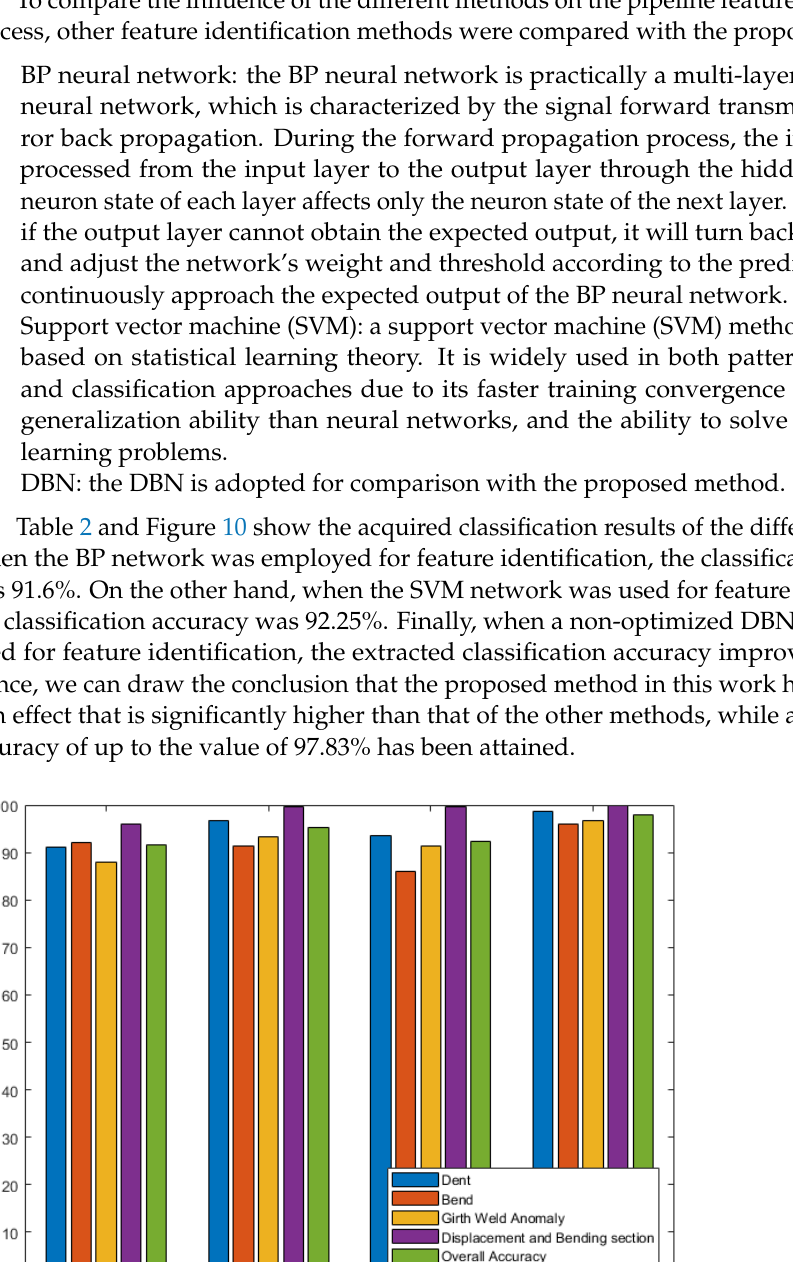
Figure 10. Accuracy comparisons with the different methods.